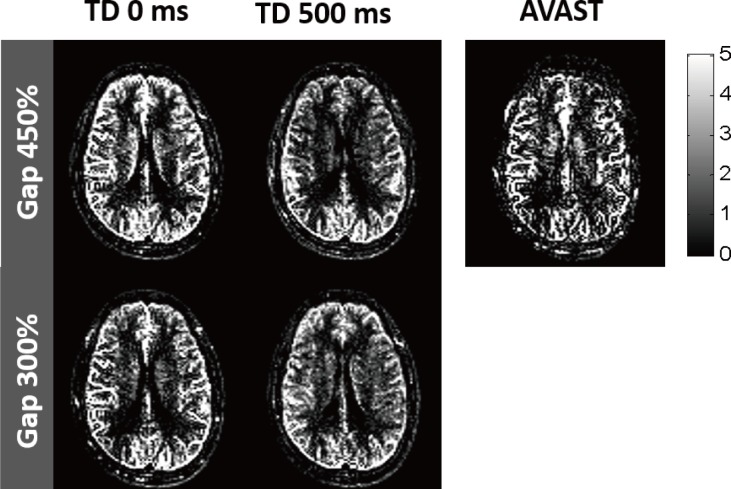
Representative aCBV maps of ALADDIN with multiphase bSSFP and AVAST.Estimated aCBV maps of ALADDIN with four different conditions and AVAST are shown, and the values in the gray scale bar are displayed in the unit of mL/100 mL.